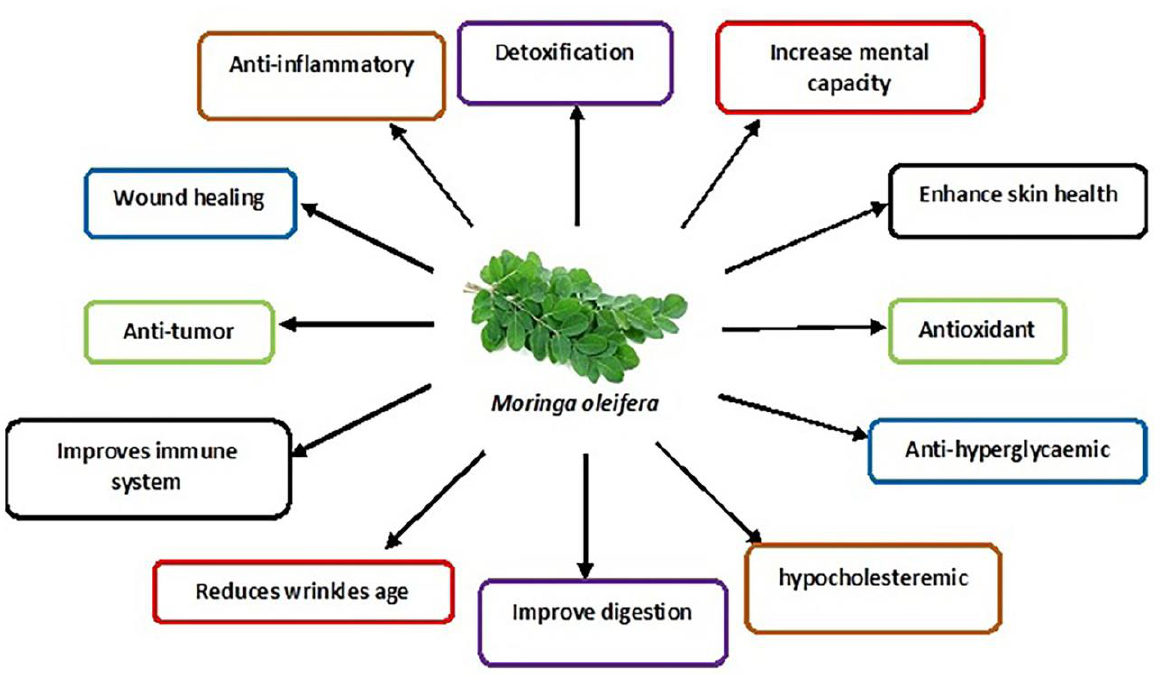
Figure 2. Schematic diagram showing various medicinal uses of M. oleifera leaves. These nutrients include proteins, vitamins (E, C, beta-carotene, B-6), minerals (calcium, phosphorus, magnesium etc.) and fatty acids [64]. The intrinsic bioactive phytonutri- ents include flavonoids, phenolic acids and glycosides. Other groups include saponins, alkaloids, tannins, isothiocyanate and glucosinolate [17]. The flavonoid group mainly include quercetin and kaempferol, with a concentration of up to 137.81 and 106.75 mg/g, respectively, found in the M. oleifera leaves. The phenolic acid in the M. oleifera leaves includes ferulic acid, gallic acid, vanillic and ellagic acid, with chlorogenic acid being the most abundant